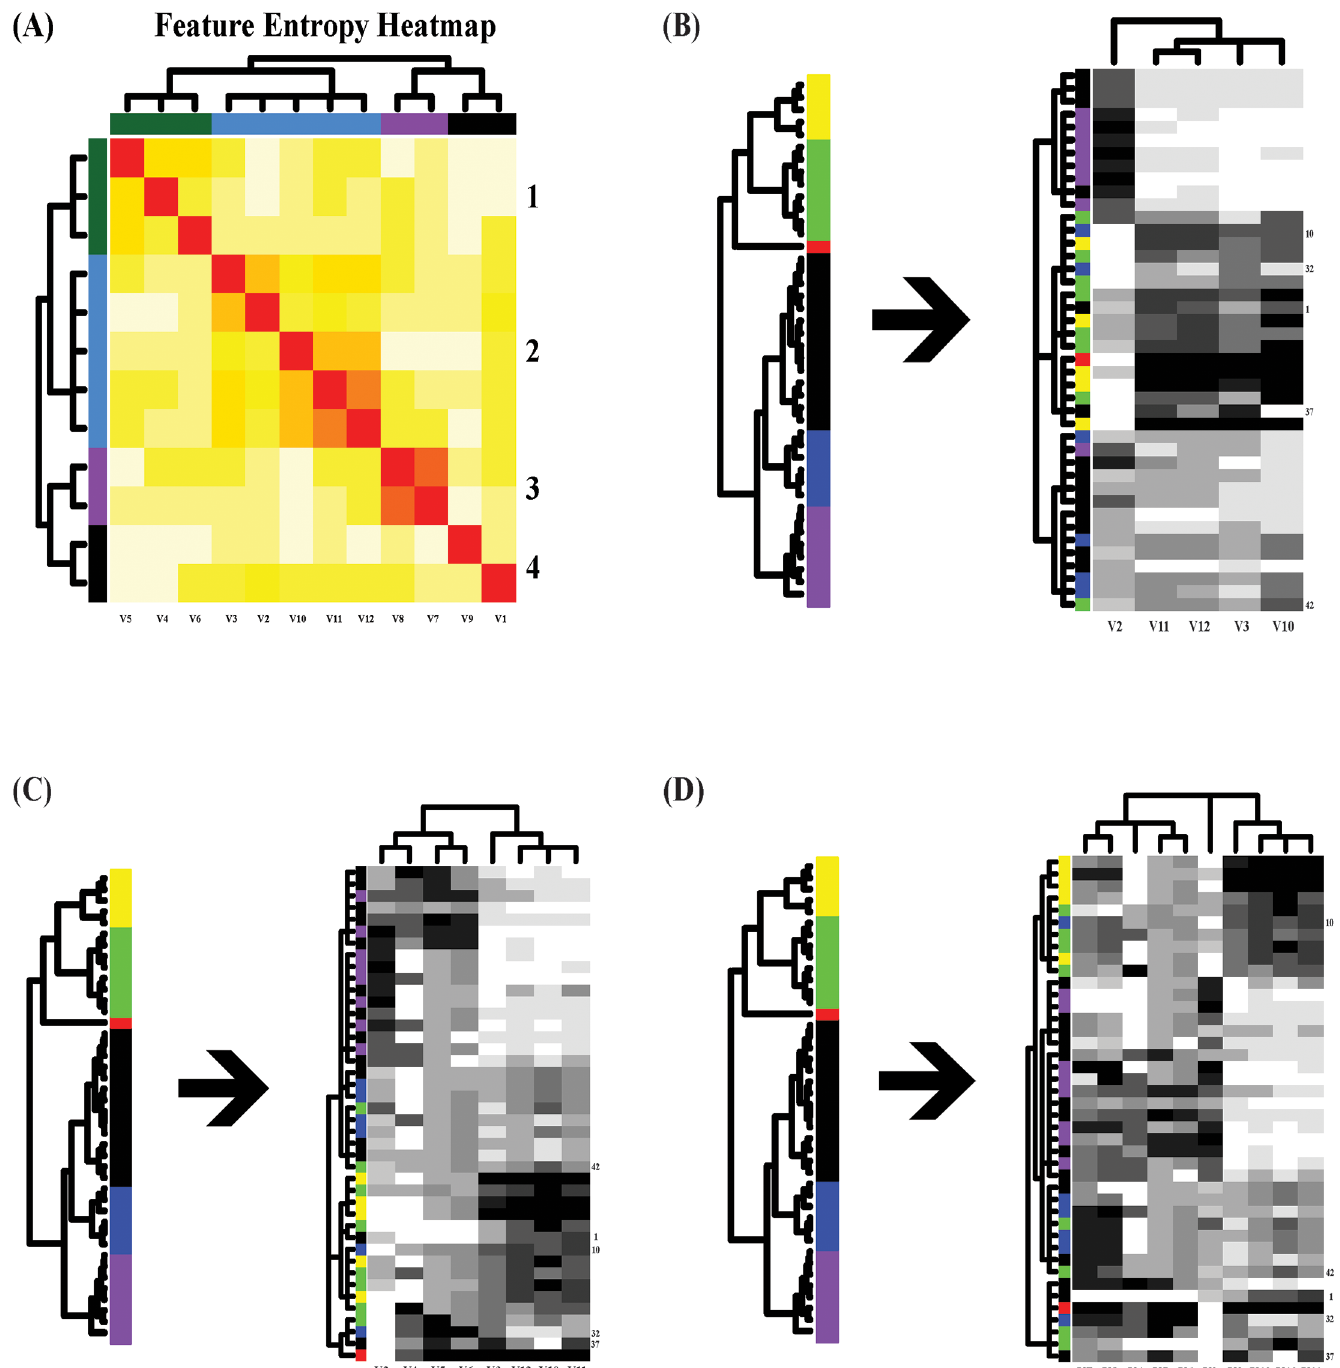
Fig 5. Information flows from response’s fine-scale perspective. (A) Mutual conditional-entropy matrix superimposed with DCG tree with 4 synergistic feature- groups; The information flows from the response to (B) #2 synergistic feature-group; (C) #1&#2; (D) #1&#2&#3 synergistic feature-groups. The misclassified subjects’ ID numbers are attached to the right side of each